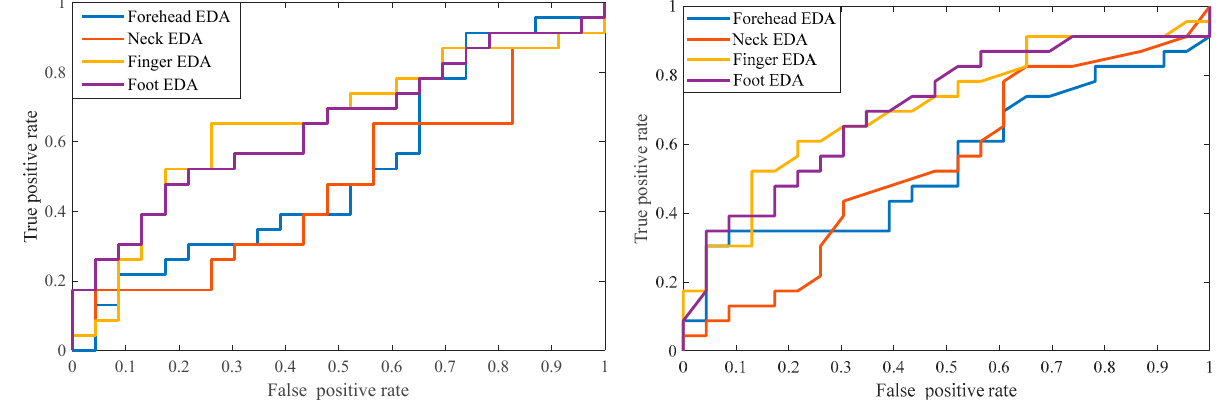
Figure 3. ROC curves for mean of the phasic signal ( left ) and number of SCR ( right ).